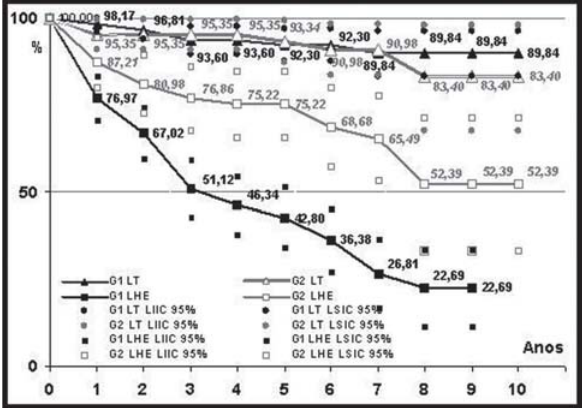
Fig. 3 - Curvas atuariais e pontos de limites superior e inferior do intervalo de confiança de 95%, de acordo com os conjuntos de grupos (G1 e G2); Livres de eventos tromboembólicos - LT e Livres de eventos hemorrágicos ou elevação exacerbada da RNI – LHE. Limite inferior do intervalo de confiança 95% - LIIC 95%; Limite superior do intervalo de confiança 95% - LSIC 95%. Os números próximos aos pontos de inflexão das curvas são referentes